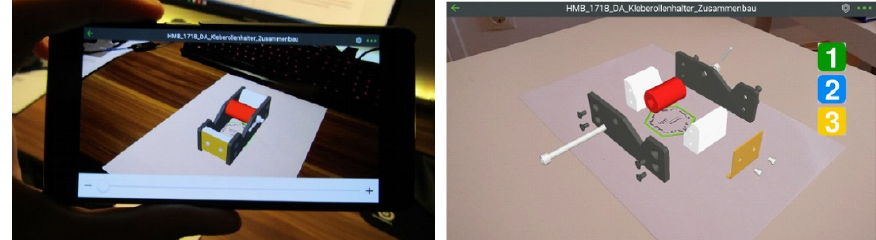
Fig. 3. 3D model data AR at the workplace of a student (left), The AR assembly steps